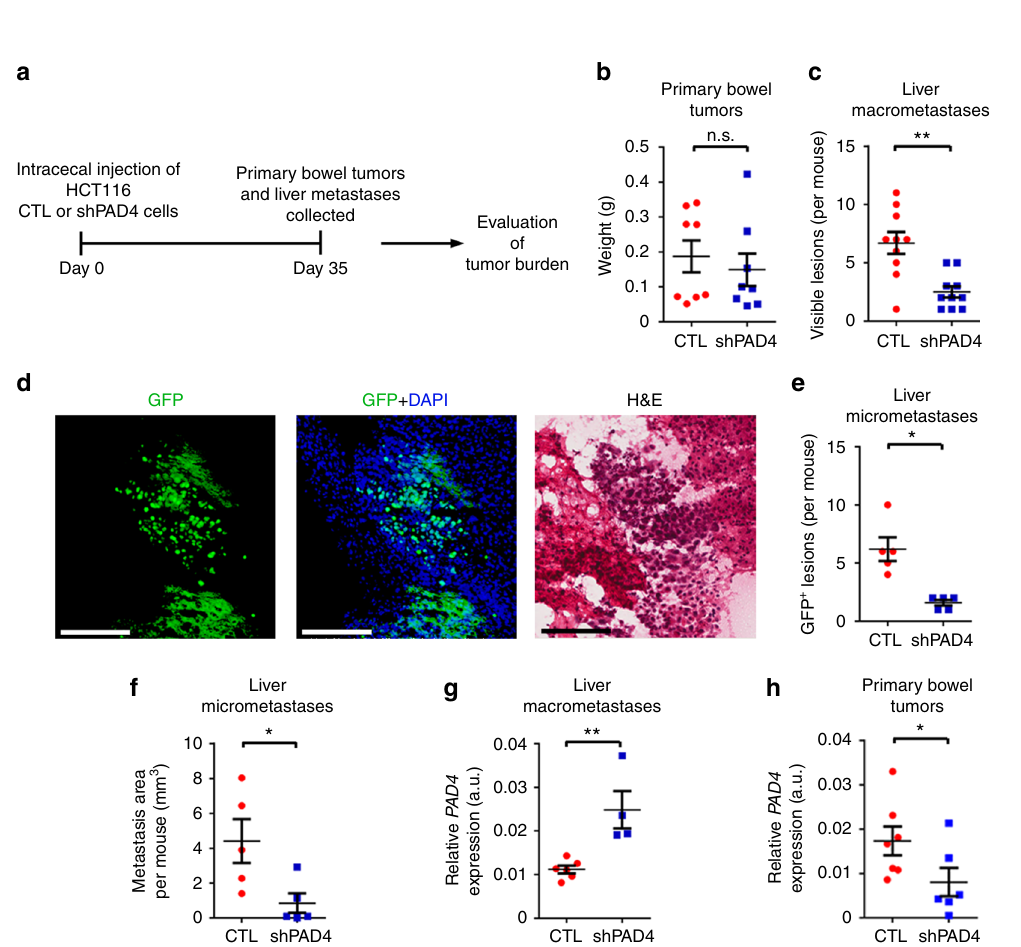
Fig. 8 Genetic downregulation of PAD4 in HCT116 cells diminishes spontaneous hepatic metastases in vivo. a Experimental pipeline. b Weight of excised primary cecal tumors ( n = 8 biological replicates per group). c Number of visible macrometastases ( n = 10 biological replicates per group). Other organs including lungs showed no evidence of metastasis. d Representative image of a GFP + metastatic lesion counterstained with DAPI (left and middle) and the corresponding H&E image (right). Scale bar = 100 μ m. e Numbers of GFP + micrometastatic lesions observed ( n = 5 biological replicates per group). f Area of micrometastases evaluated by H&E ( n = 5 biological replicates per group). g Relative (to HPRT) mRNA levels of PAD4 in visible macrometastases ( n = 6 and 4 for CTL and shPAD4 groups, respectively). h Relative (to HPRT) mRNA levels of PAD4 in primary cecal lesions ( n = 7 and 6 for CTL and shPAD4 groups, respectively). Throughout, error bars indicate s.e.m. center values indicate mean (* P < 0.05, ** P < 0.01, n.s. = non-signi fi cant, Mann – Whitney U test). CTL control, shPAD4 PAD4 knockdown, H&E hematoxylin and eosin